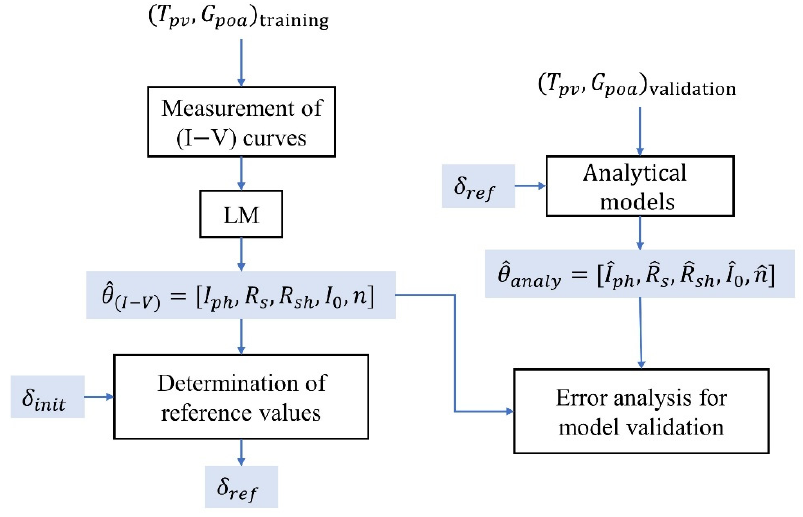
Figure 11. Methodology for parameters extraction.